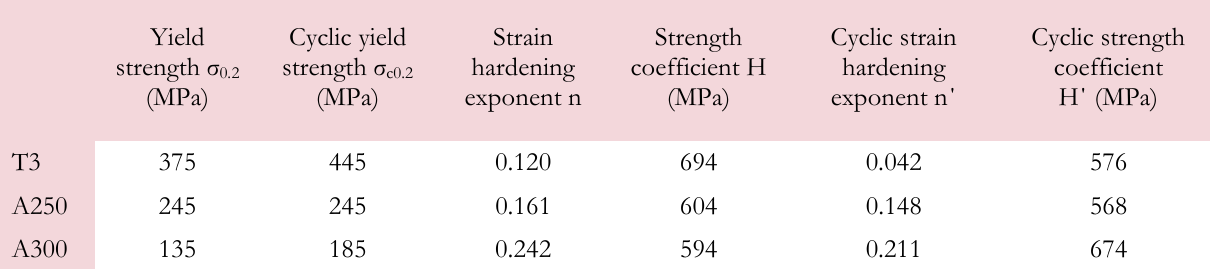
Table 1: Cyclic and monotonic properties of T3, A250 and A300 materials.